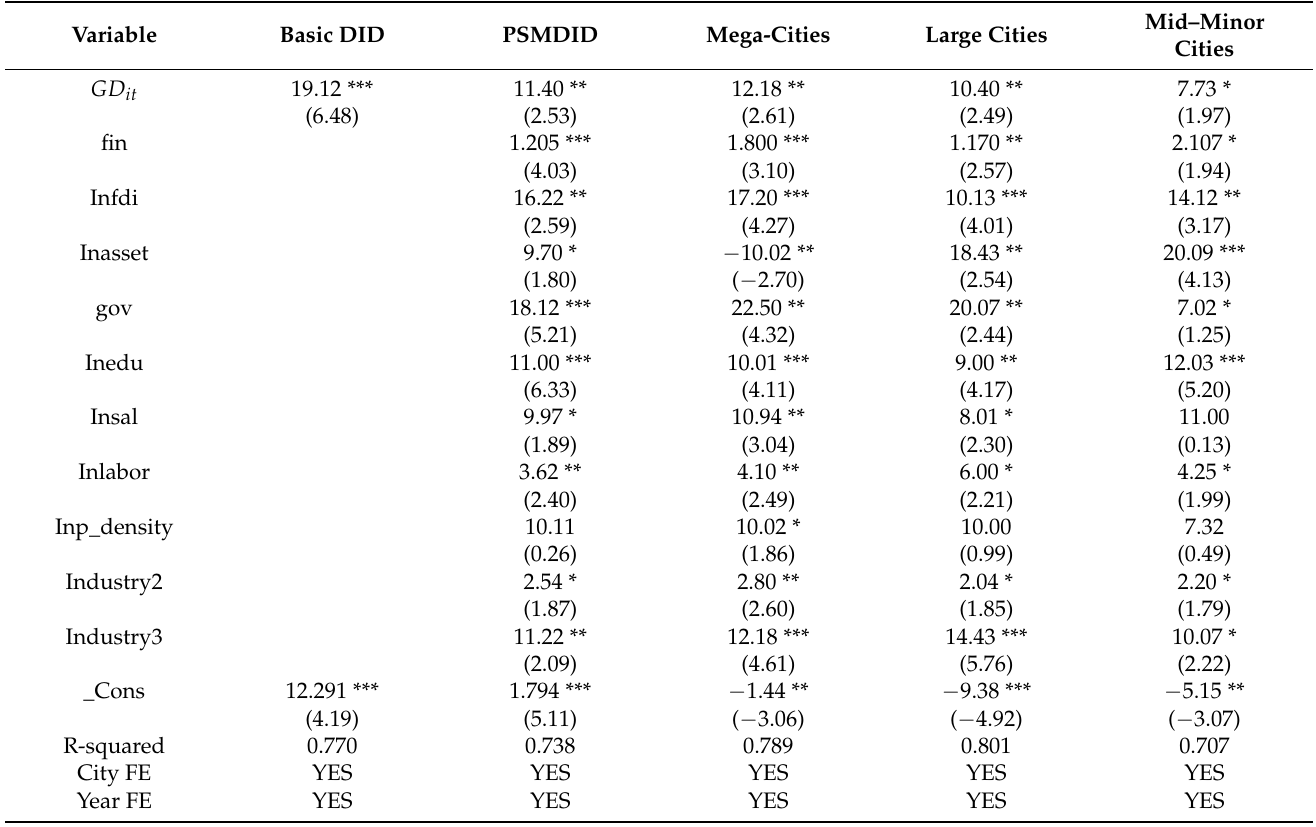
Table 6. Regression analysis of urban innovation bonus (science and technology